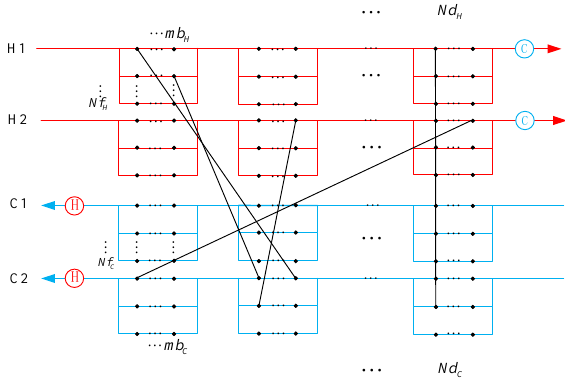
Figure 1. The schematic representation of NNM with series structure.